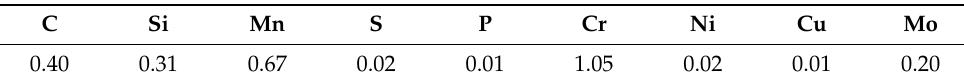
Figure 2. ( a ) The electric-resonant fatigue testing bench and ( b ) the dimensions of the resonant system. Table 1. Chemical compositions of 42CrMo steel (wt.%). Table 1. Chemical compositions of 42CrMo steel (wt.%).